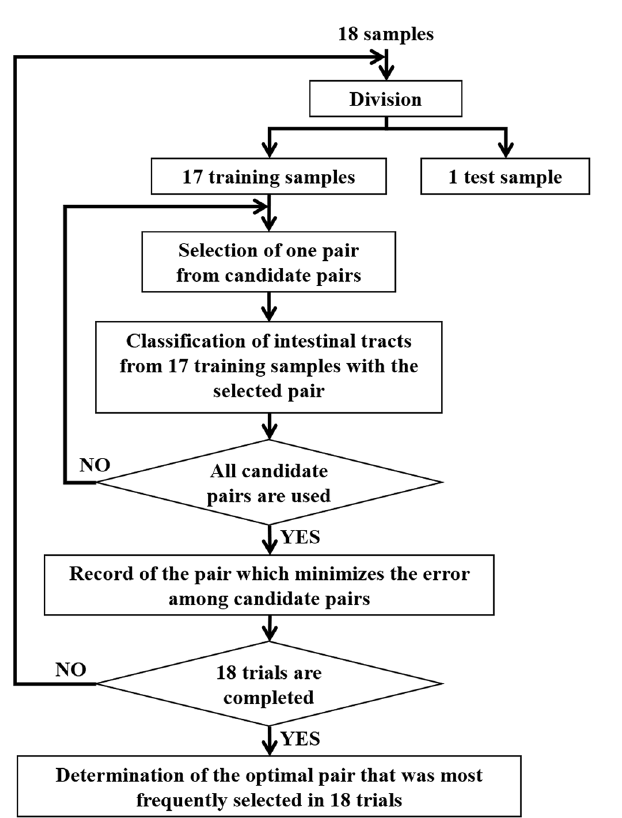
Figure 6. ( a ) Scheme of assessment of intestinal motility. It is deemed to have impaired motility if x 1 ≥ α and x 2 ≤ β, where α and β are the threshold values. An intestinal tract that had no impairment in motility satisfies the condition x intestinal tracts with impaired motility was detected.